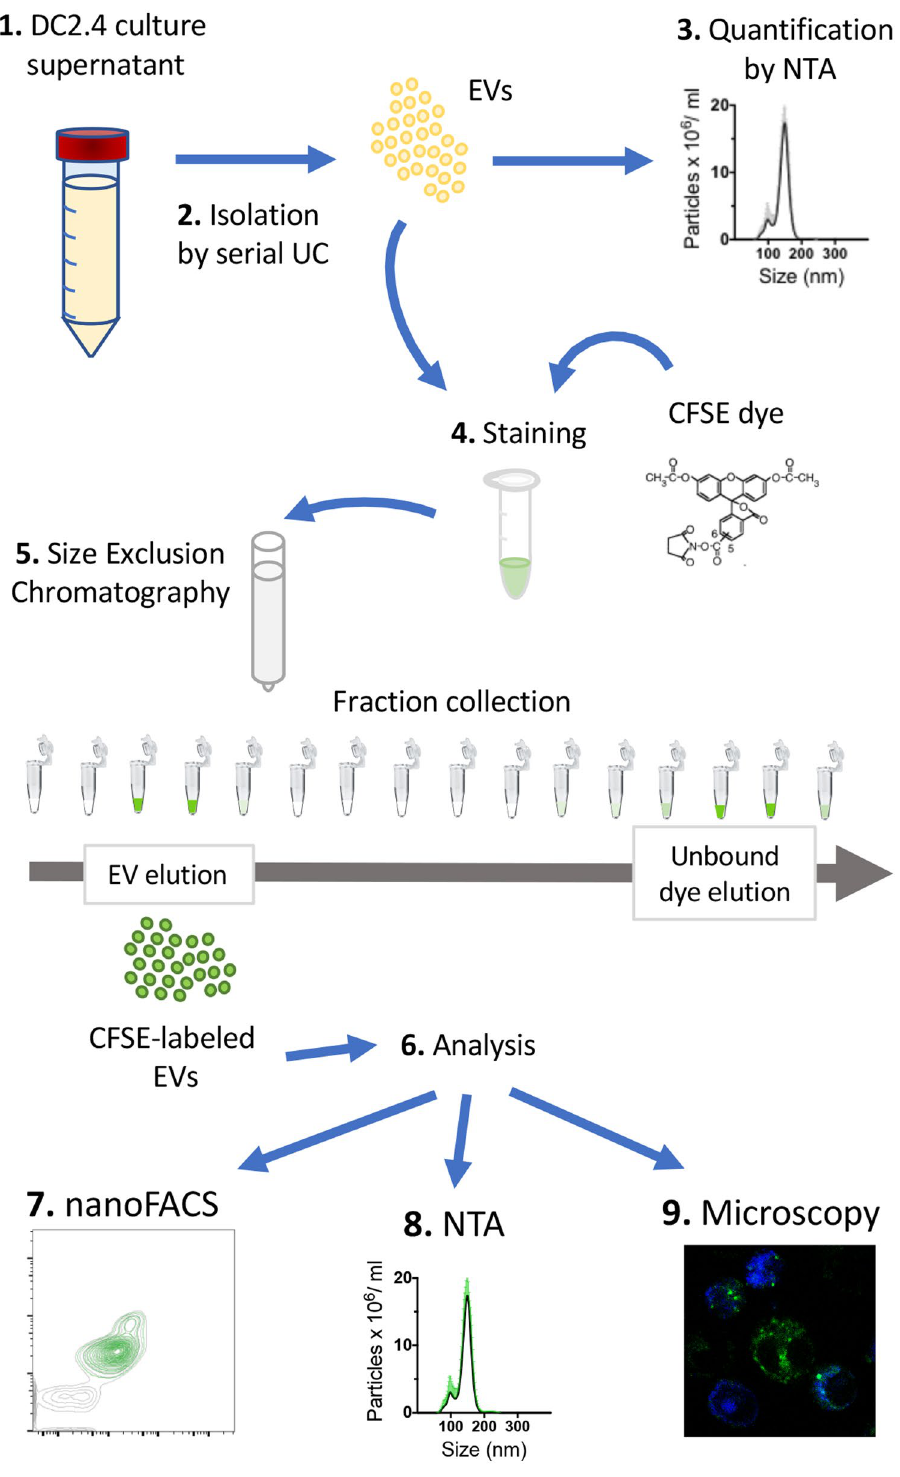
Figure 1. Summary of the workflow for the methods described in this manuscript. DC2.4 cells were cultured in EV-depleted medium without phenol red to produce EV containing supernatants (1). Then, EVs were isolated by serial ultracentrifugation 31 (2) and concentration and size distribution characterized by NTA (3). Afterwards, EVs were stained with CFSE (4) or other dyes (not depicted here) and free dye was washed by size exclusion chromatography (5). CFSE-labeled EVs eluted in fractions 3 and 4 were used for their analysis (6) by different methods: nanoFACS (7), NTA (8) and microscopy (9). UC, ultracentrifugation; EV, extracellular vesicle; NTA, Nanoparticle Tracking